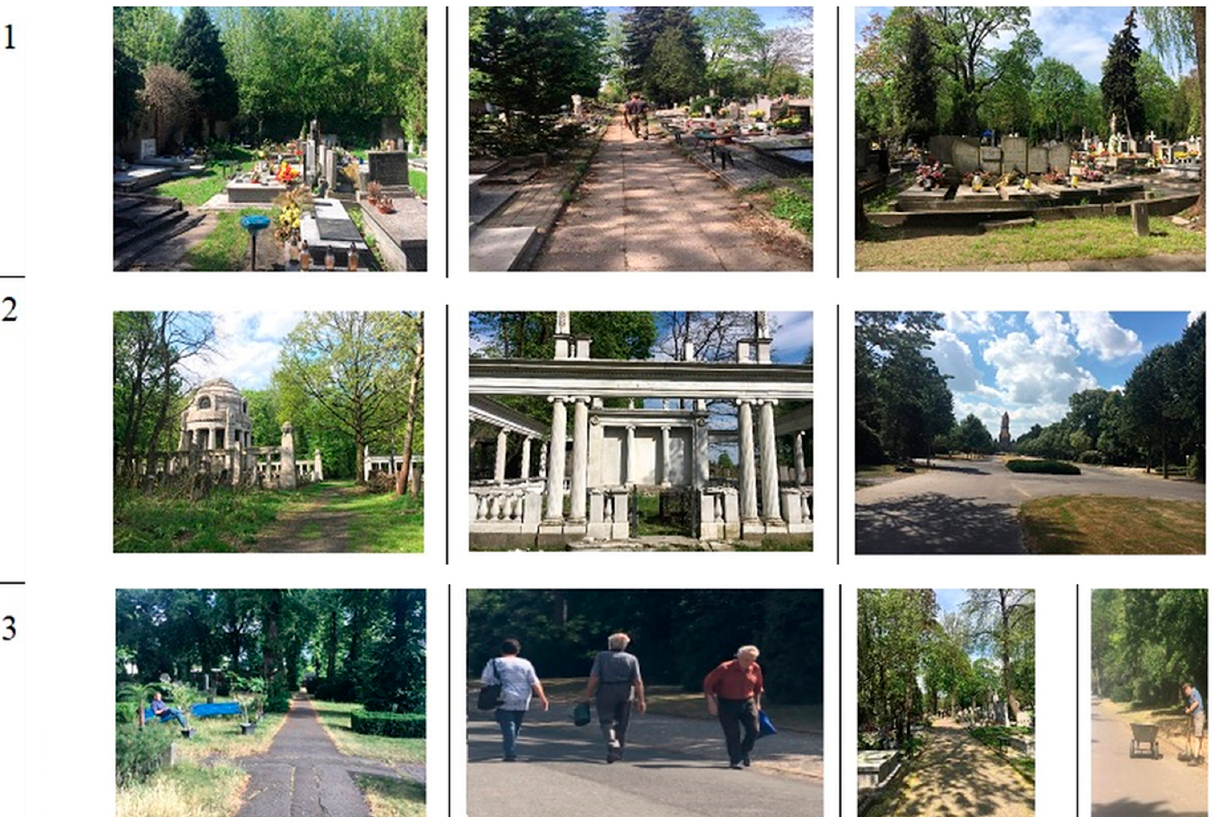
Figure 7. The most common activities carried out in the cemeteries in Ł ód ź and Leipzig. Legend: